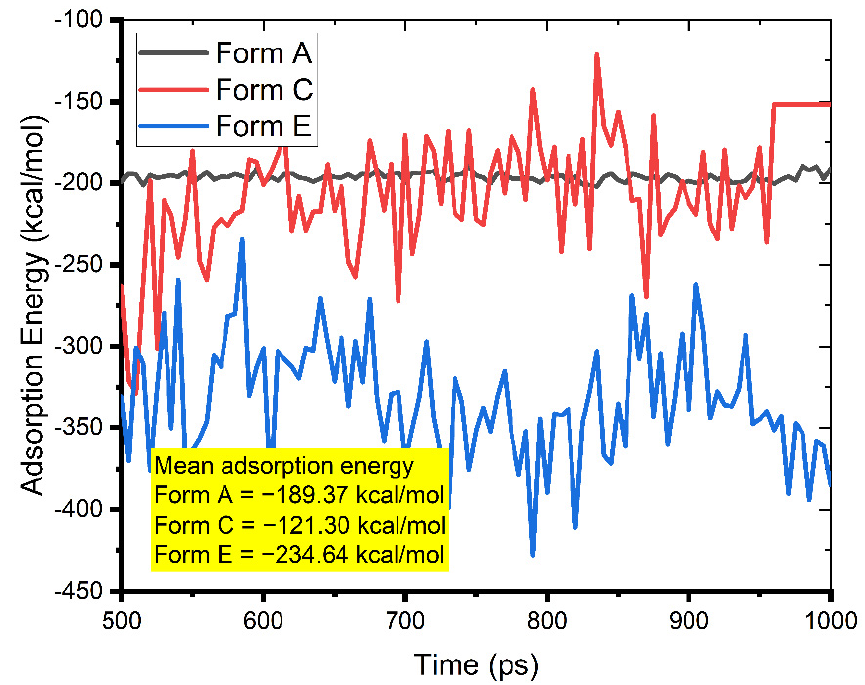
Figure 9. Evolution of the adsorption energy during the MD run in the simulated corrosion media during the interaction of Pantoprazole (Form A, C, and E) with the Fe (1 1 0) surface in the simulated corrosion media (the corresponding mean values of the interaction energies are presented in the graph).